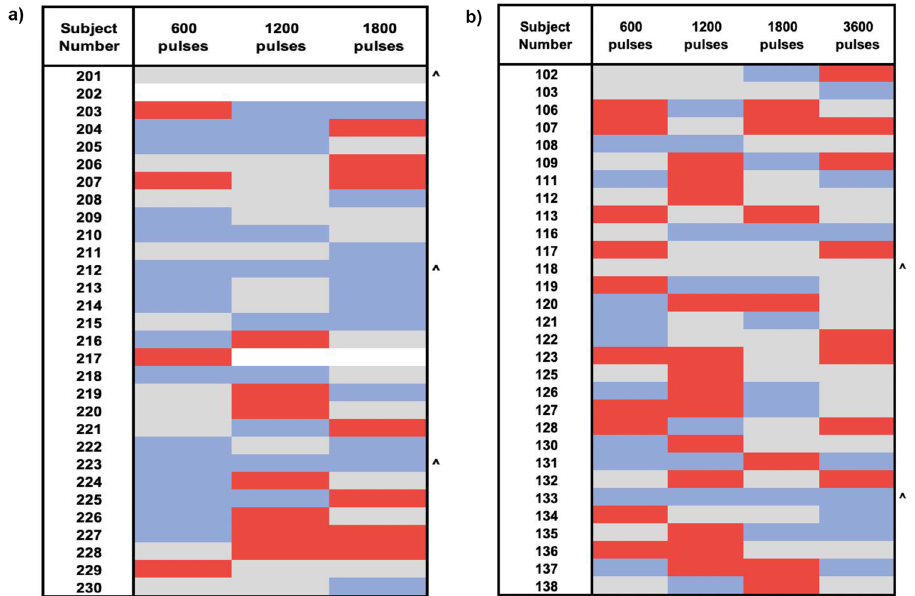
Figure 3. Individual Response to TBS protocols. Colored grid shows the breakdown of inhibitory (blue), excitatory (red) or no change (grey) responses following ( A ) iTBS and ( B ) cTBS doses in each individual. ^ indicates individuals who consistently responded in the same direction to all real TBS